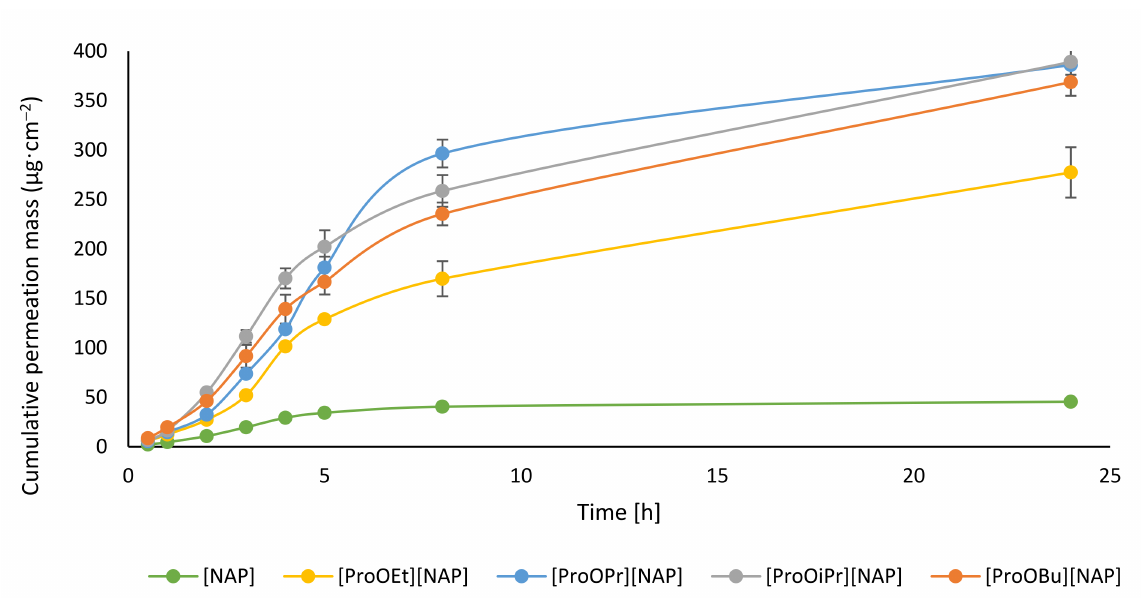
Figure 9. Time course of the cumulative mass of naproxen and its derivatives during the 24 h permeation. 1 cm 3 of PBS (pH 7.4) containing a constant concentration of compounds was placed in each donor chamber (Mean ± SD, n = 3). Statistically significant difference was estimated using the ANOVA test. Table 7. Cumulated mass for naproxen and its derivatives; different letters indicate significant differences between the tested compounds, α = 0.05, mean ± SD, n = 3. Statistically significant difference was estimated using the ANOVA test.